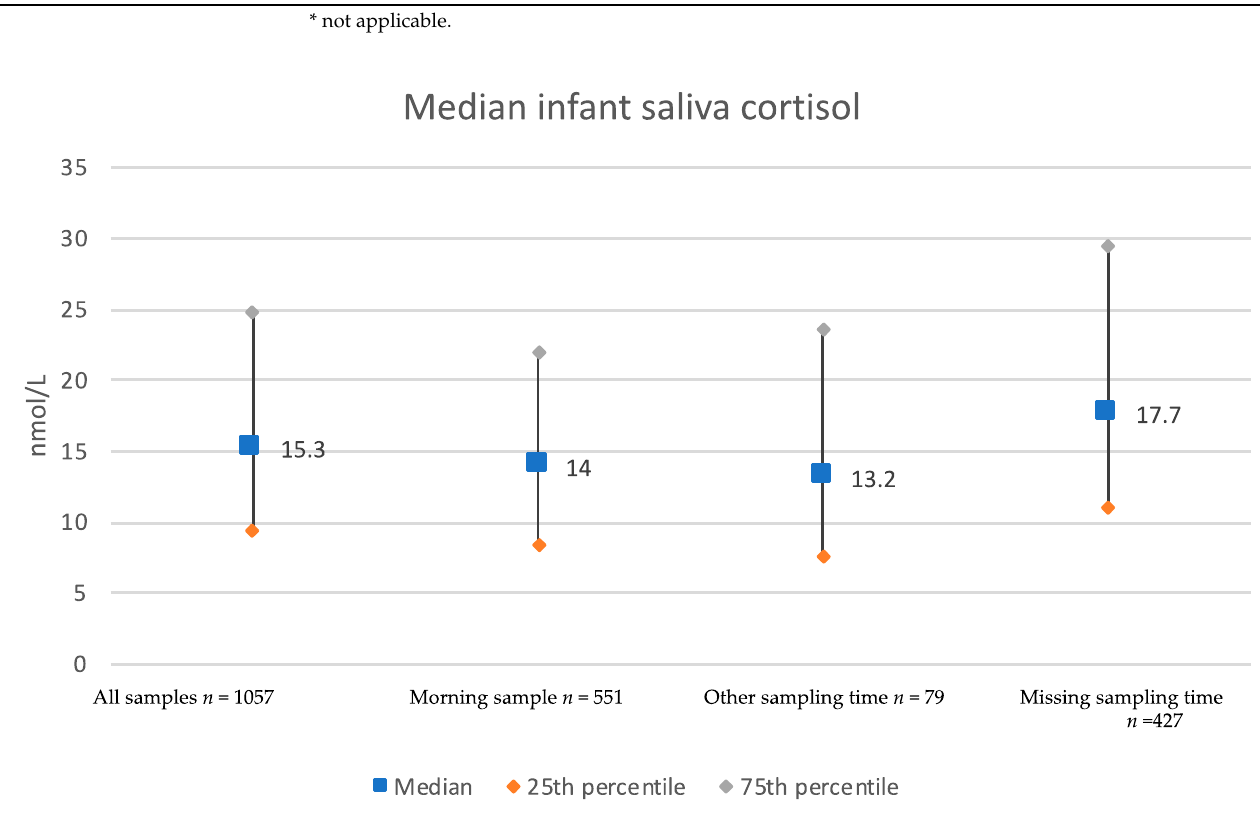
Figure 2. Infant saliva cortisol levels related to sampling time ( n = 1057). Values are given in median (nmol/L), blue large squares) and inter quartile range (25th—75th percentile).